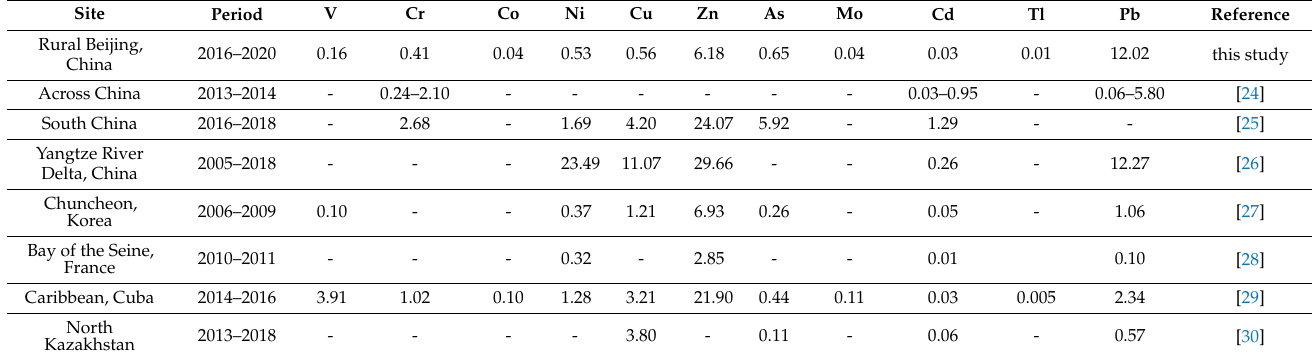
Table 2. Summary of bulk deposition flux (mg m − 2 year − 1 ) of 11 MMs in this study and other measurement sites. Site Period